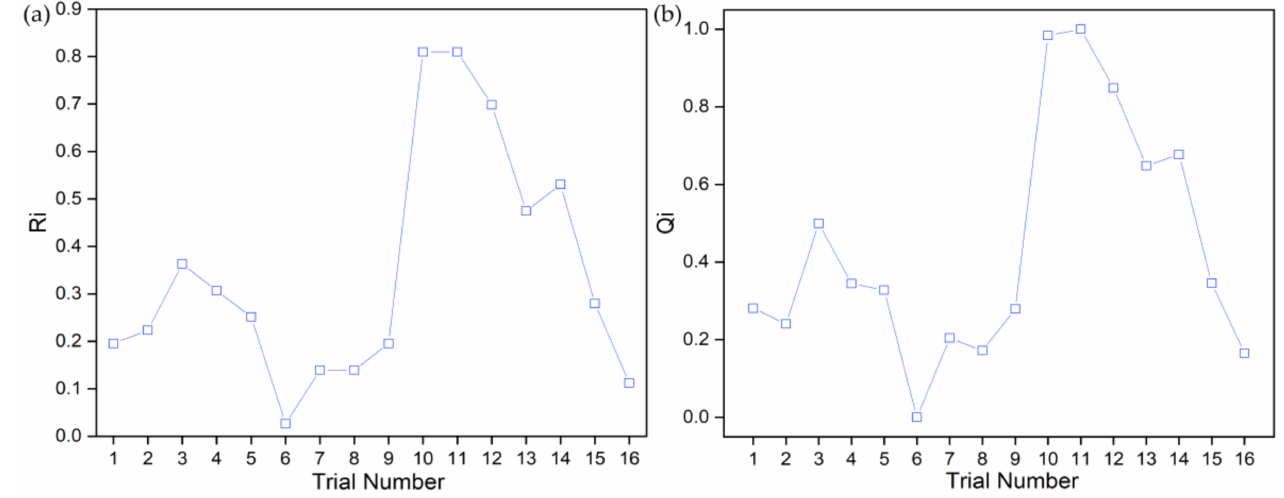
Figure 7. ( a ) R i and ( b ) Q i values in VIKOR method for case study 1. When all the trials are ranked based on their Q i indexes, it can be unveiled that trial number 6 evolves out as the optimal combination of manufacturing process parameters for brake lining material. Finally, the normalized assessment values in the MOORA method are computed applying Equation (23). When these values are plotted in Figure 8, trial number 6 provides the optimal parametric intermix for this case